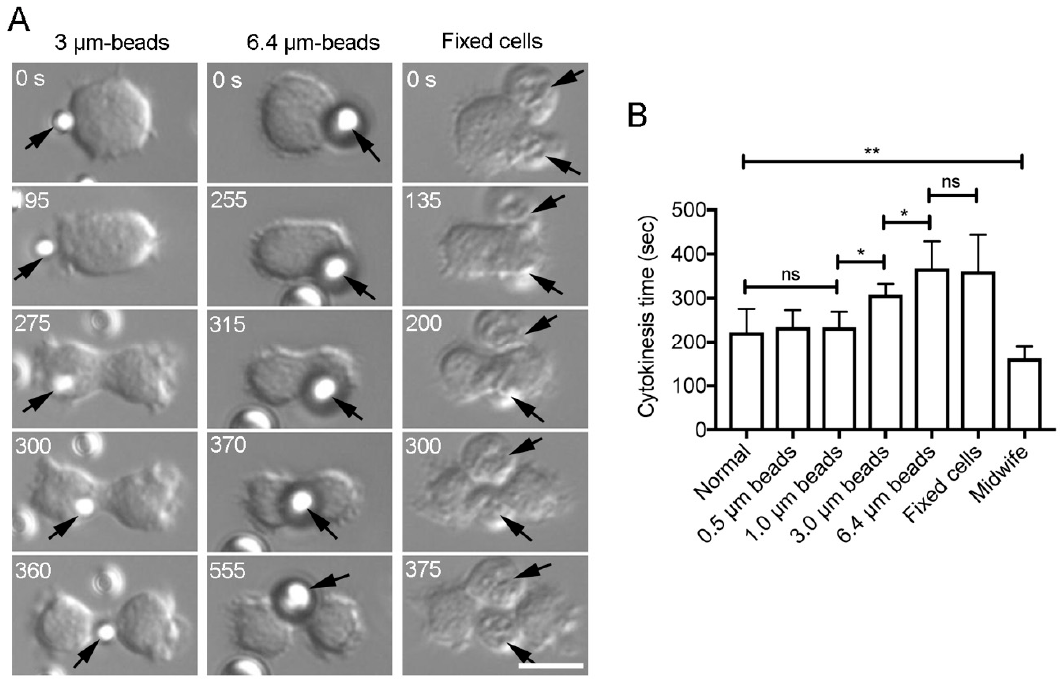
Figure 6. The cortical flow of attached beads. ( A ) Representative time course data on the movement of beads (3 µm and 6.4 µm in diameter) and fixed cells attaching to dividing cells. Note that the beads and the fixed cells (arrows) move toward the cleavage furrow. Bar, 10 µm. ( B ) Cytokinesis time when the beads or fixed cells were attached to dividing cells. Data are presented as mean ± SD (n > 40, three experiments). * P ≤ 0.001. ** P ≤ 0.0001. ns: not significant, P > 0.05.